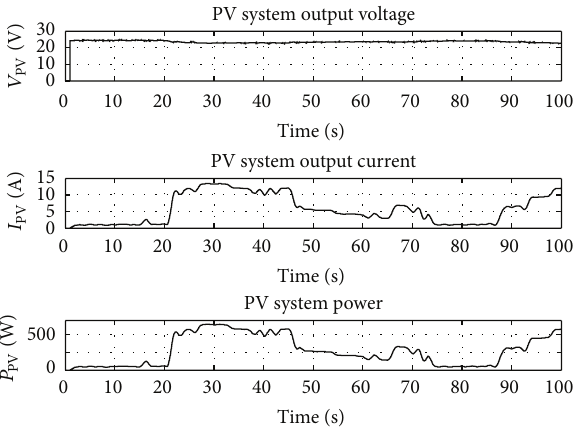
Figure 21: Current, voltage, and power change of PV system in case 2.